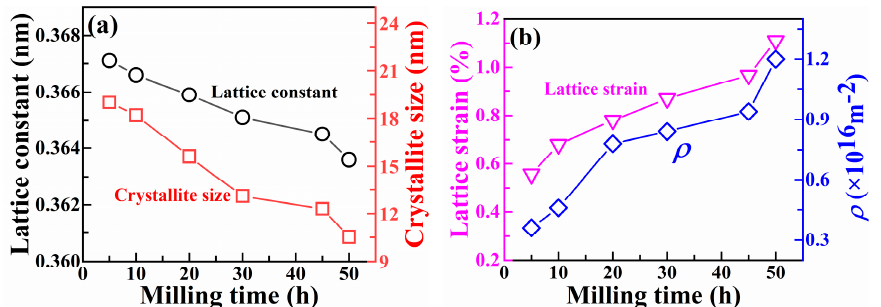
Figure 2. Relevant parameters of FCC phase in Ni 0 HEAP after different ball milling time: ( a ) grain size and lattice constant; ( b ) lattice strain and dislocation density.